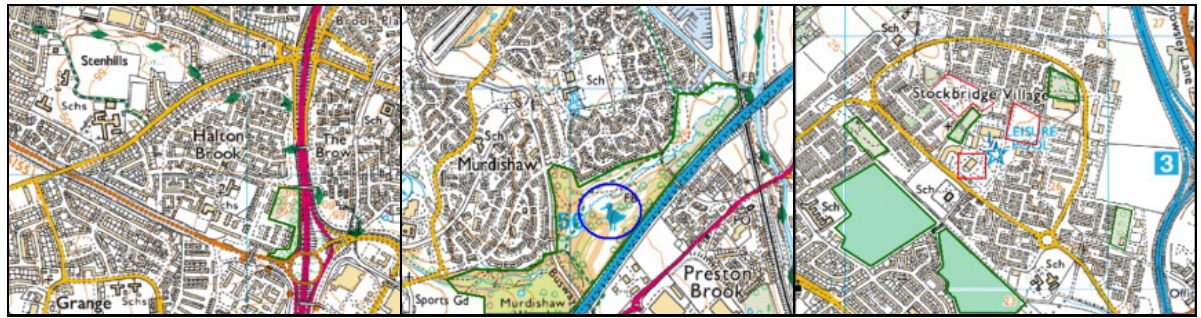
Figure 4. Environment in Halton Brook (HB), Murdishaw, and Stockbridge Village (SV). Area of urban green space encircled in green, area of marina village–in blue, area of derelict land–in